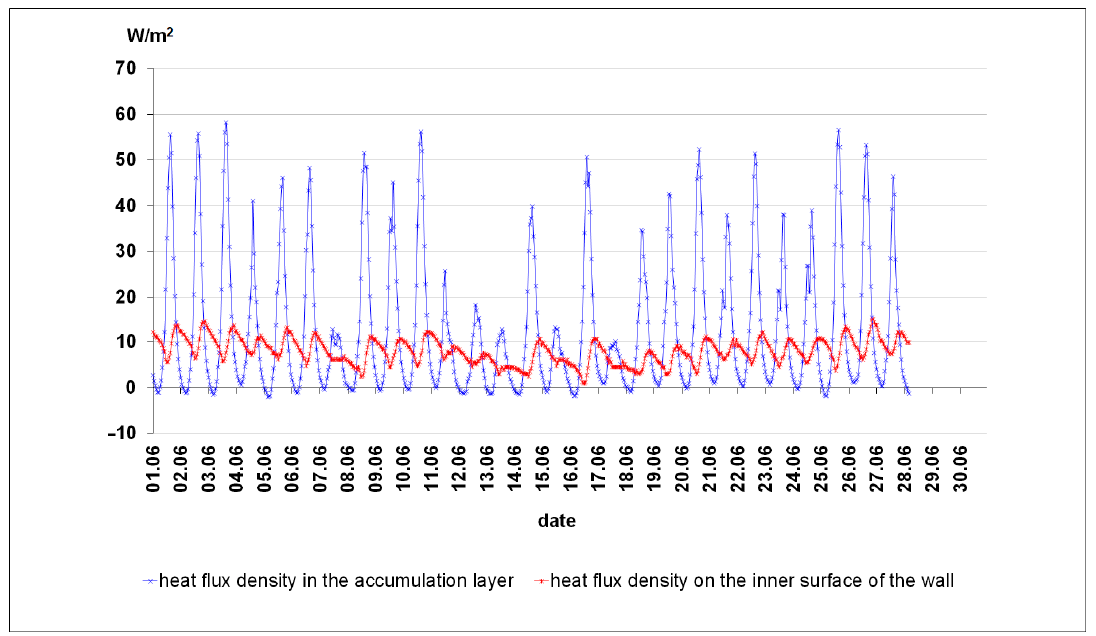
Figure 13. Graph of heat flux density flowing through the storage layer and on the inner surface of the wall in June.